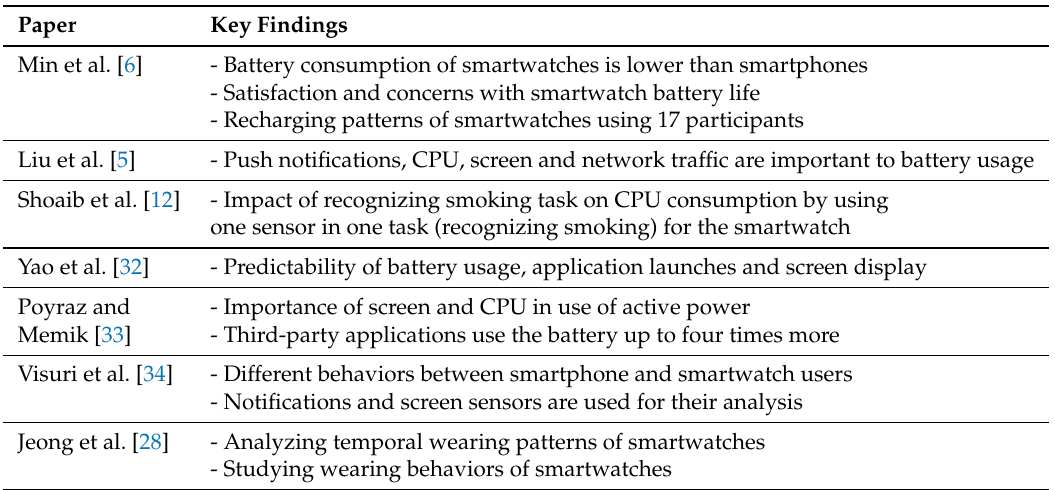
Table 1. Summary of findings in state-of-the-art smartwatch battery utilization